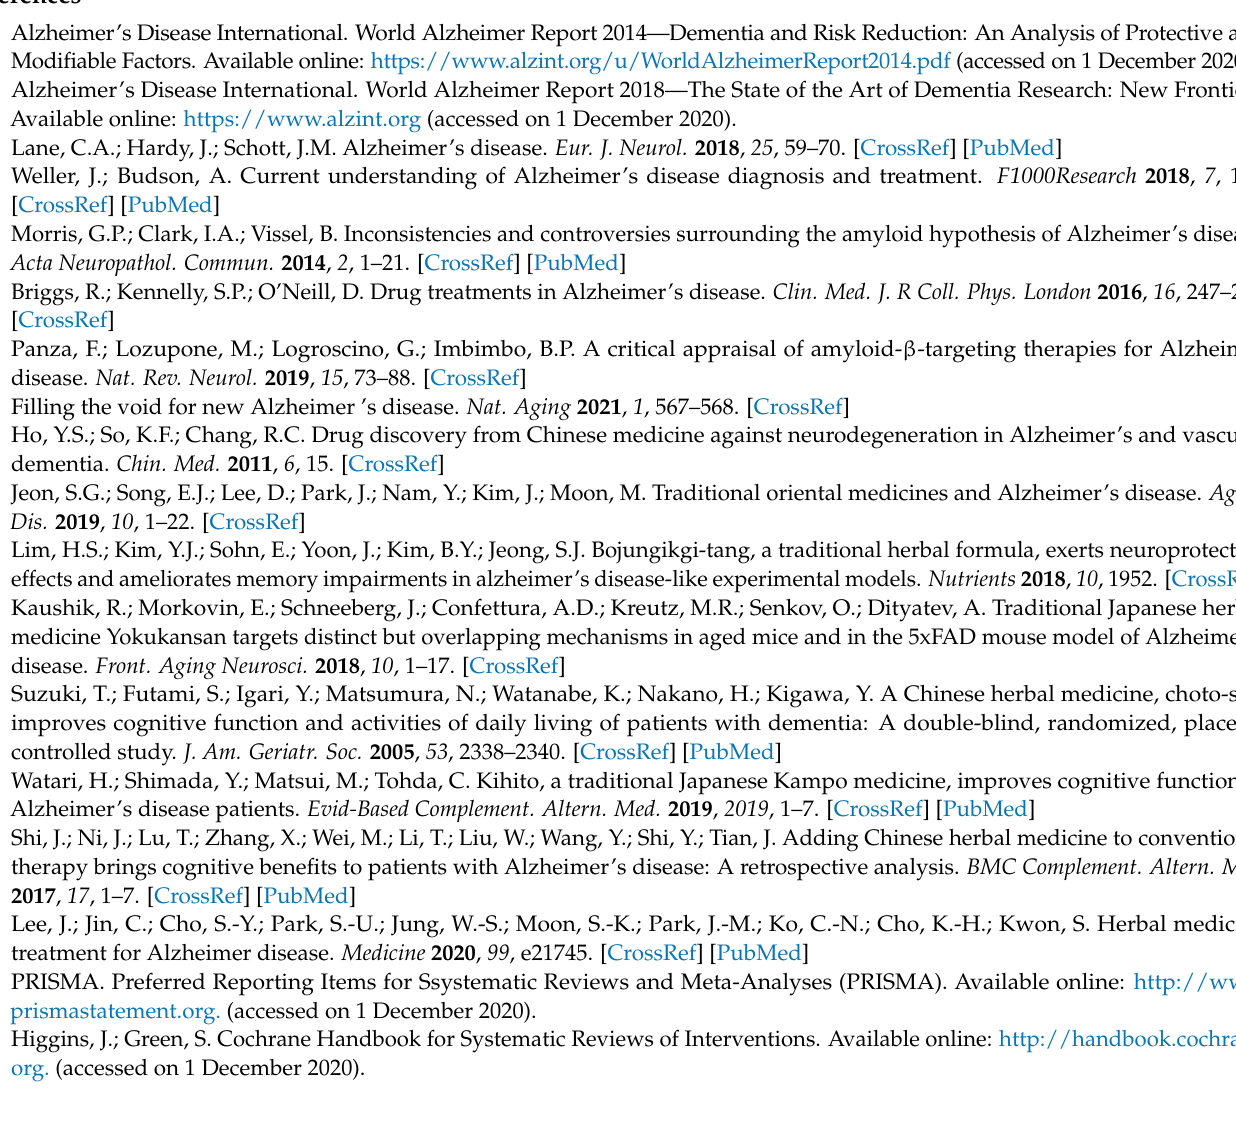
Figure A2. Funnel